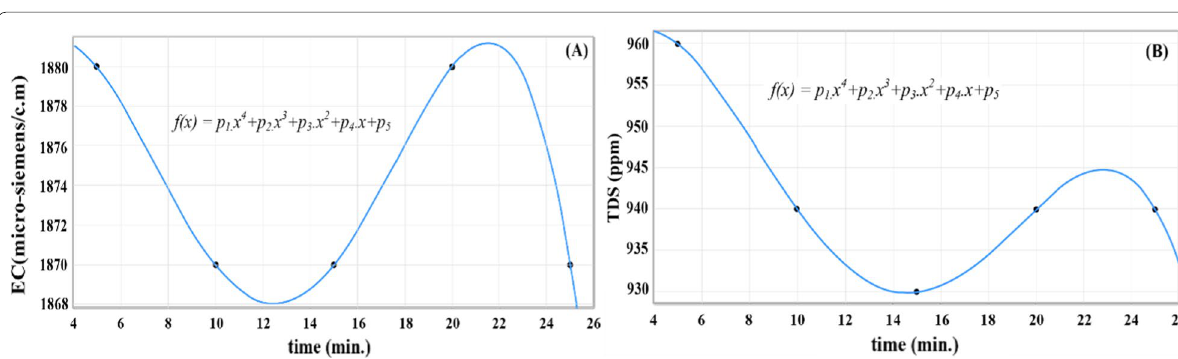
Fig. 8 Brackish groundwater in case of closed cycle at flow rate of 52.16 l/min: A electrical conductivity versus time and B total dissolved solids versus time